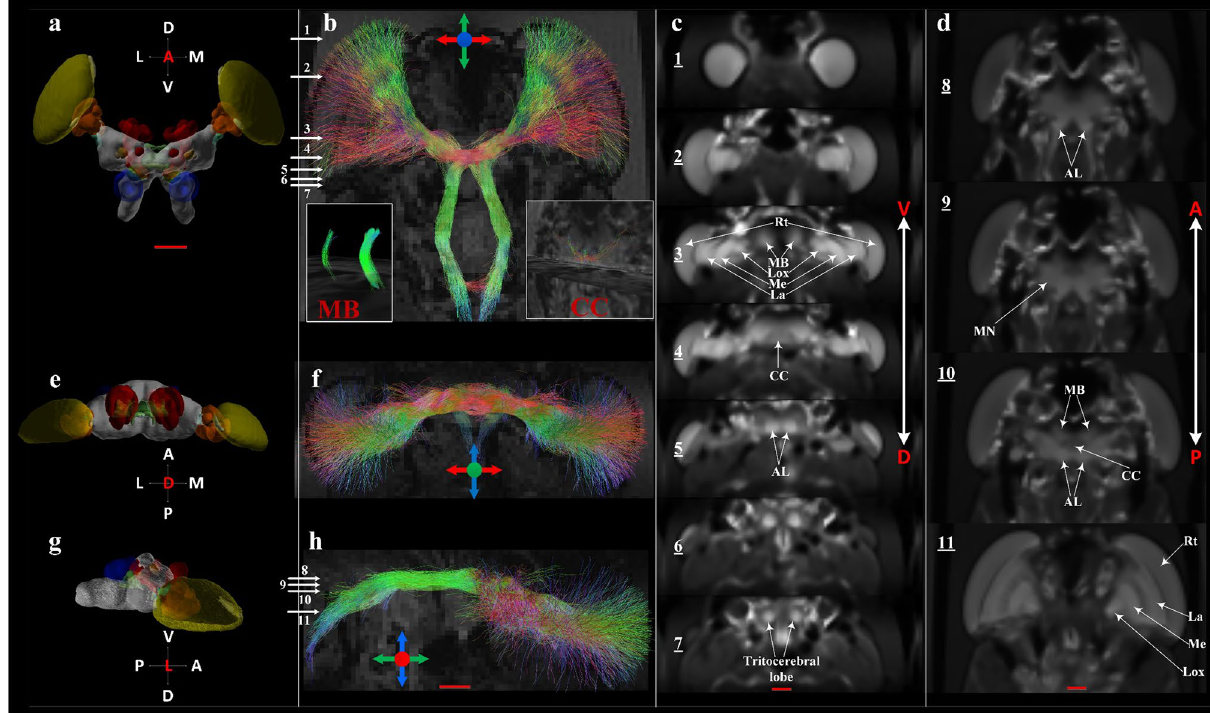
Figure 4. Anatomical regions and tract connectivity derived from dMRI in an ex-vivo locust. ( a ) Anterior view of 3D surface reconstruction taken from http://insec tbrai ndb.org 44 . ( b ) Projections of directionally encoded tracts from synaptic neuropils in one of the ex-vivo samples. The colours in crosshair represent the direction of 3D tract projections (coronal slice, anterior view). ( c ) Insets 1–7 show locations of anatomical structures in axial planes (ventral to dorsal) using the map obtained from the arithmetic average of 26 diffusion-encoding directions. ( d ) Insets 8–11 show locations of anatomical regions in coronal planes (anterior to posterior) using averaged DWIs. ( e ) Dorsal view of 3D surface reconstruction taken from http://insec tbrai ndb.org 44 . ( f ) Directionally encoded tracts from synaptic neuropils (axial slice, dorsal view). The colours in crosshair represent the direction of 3D tract projections. ( g ) Lateral view of 3D surface reconstruction taken from http://insec tbrai ndb.org 44 . ( h ) Projections of directionally encoded tracts from synaptic neuropils (sagittal slice, lateral view). The colours in crosshair represent the direction of 3-D projections. AL antennal lobe, CC central complex, La lamina, Lox lobula complex, MB mushroom body, Me medulla, MN midbrain neuropil, P peduncles, Rt retina. Scale bar 500